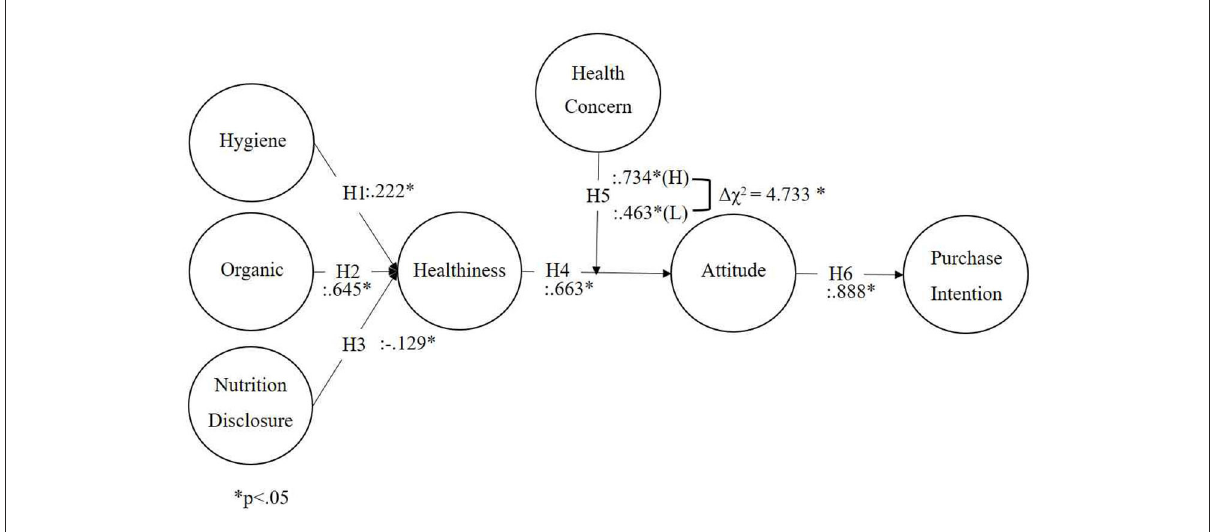
FIGURE2 Results of structural equation